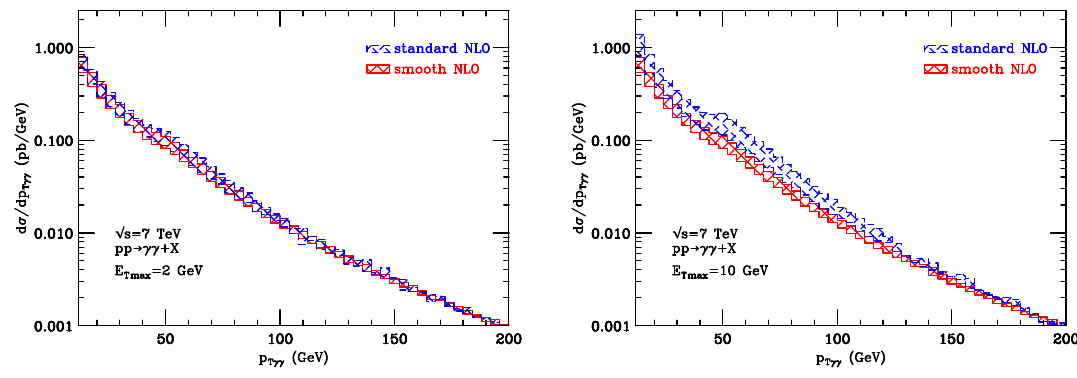
Figure 8 . The NLO results (scale variation bands) for the p Tγγ differential cross section that are obtained by using the smooth (red solid band) and standard (blue dashed band) cone isolation cri- teria with E T max = 2 GeV (left panel) and E T max = 10 GeV (right panel). The photon kinematical cuts are the same as in figure